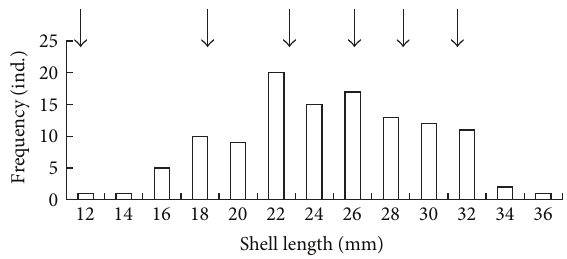
Figure 4: Distribution of shell lengths in the Ruditapes bruguieri sample from the eastern coast of Jeju Island. Arrows indicate the shell lengths of clams with 1, 2, 3, 4, 5, and 6 annual winter rings,